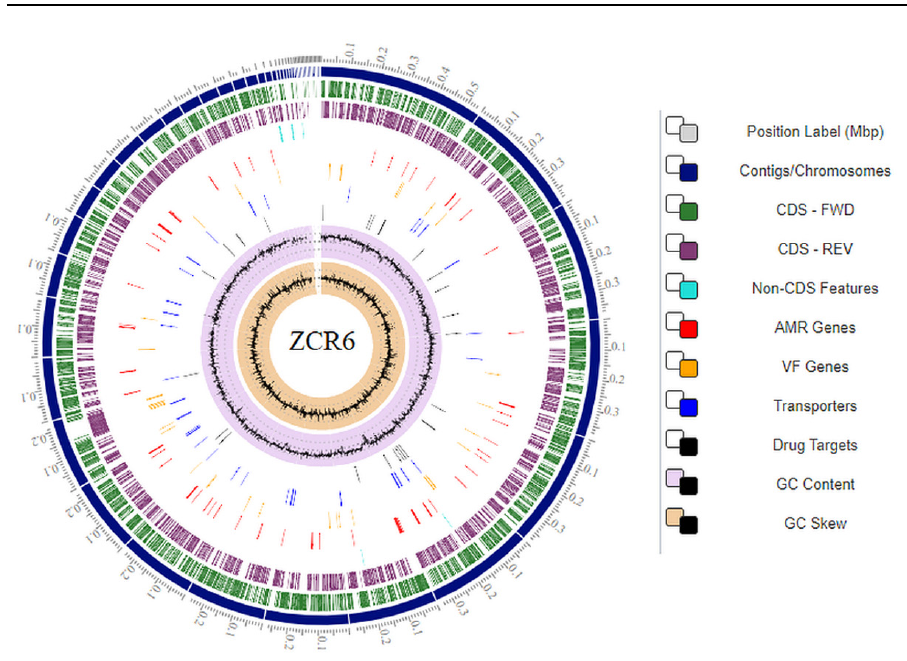
Figure 2. Circular plot representing the genome annotations of the ZCR6 strain. Colors depict the different classification types of gene clusters along the sequenced genome. The description of each circle is represented from the outermost circle to the innermost circle. Tick marks represent the predicted CDS on the positive and negative strands. AMR—antimicrobial resistance genes; VF—virulence factor genes.